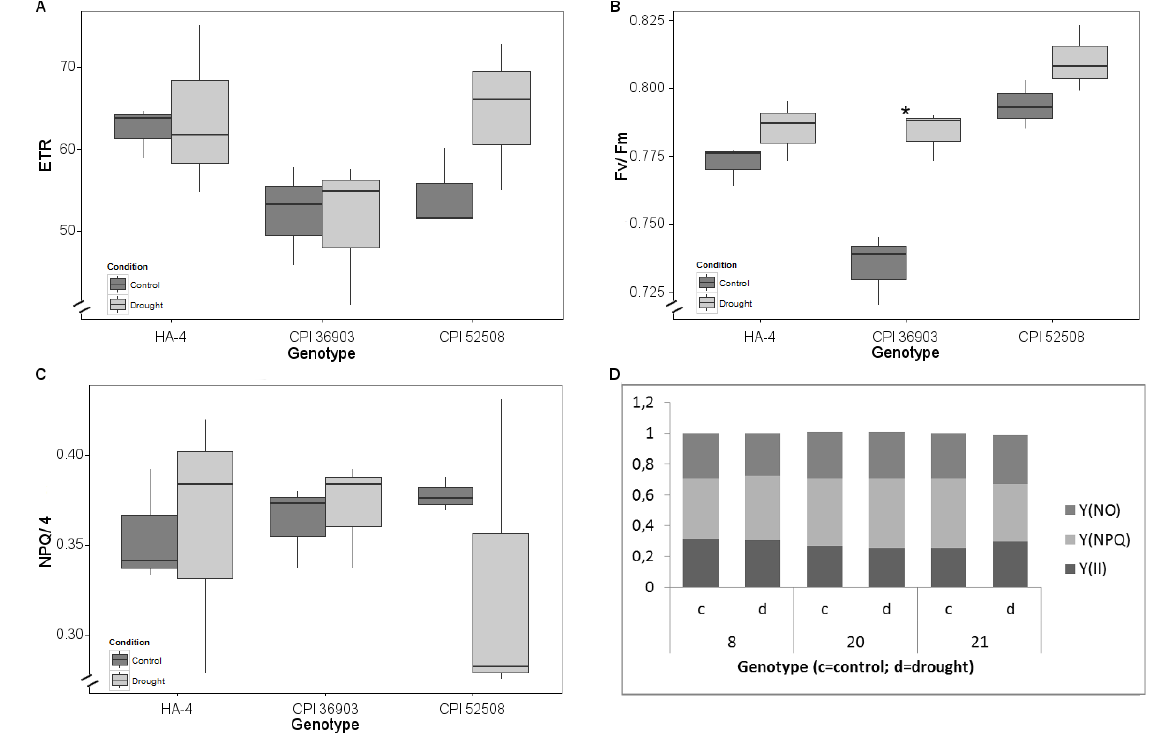
Fig. 6: Effects of water limitation after nine days on (A) ETR, (B) Fv/ Fm and under LL conditions through chlorophyll fluorescence analysis (C) NPQ/4, (D) Y(II) Y(NO) Y(NPQ); n=3, genotypes with * = p <0.05, exp. 2.